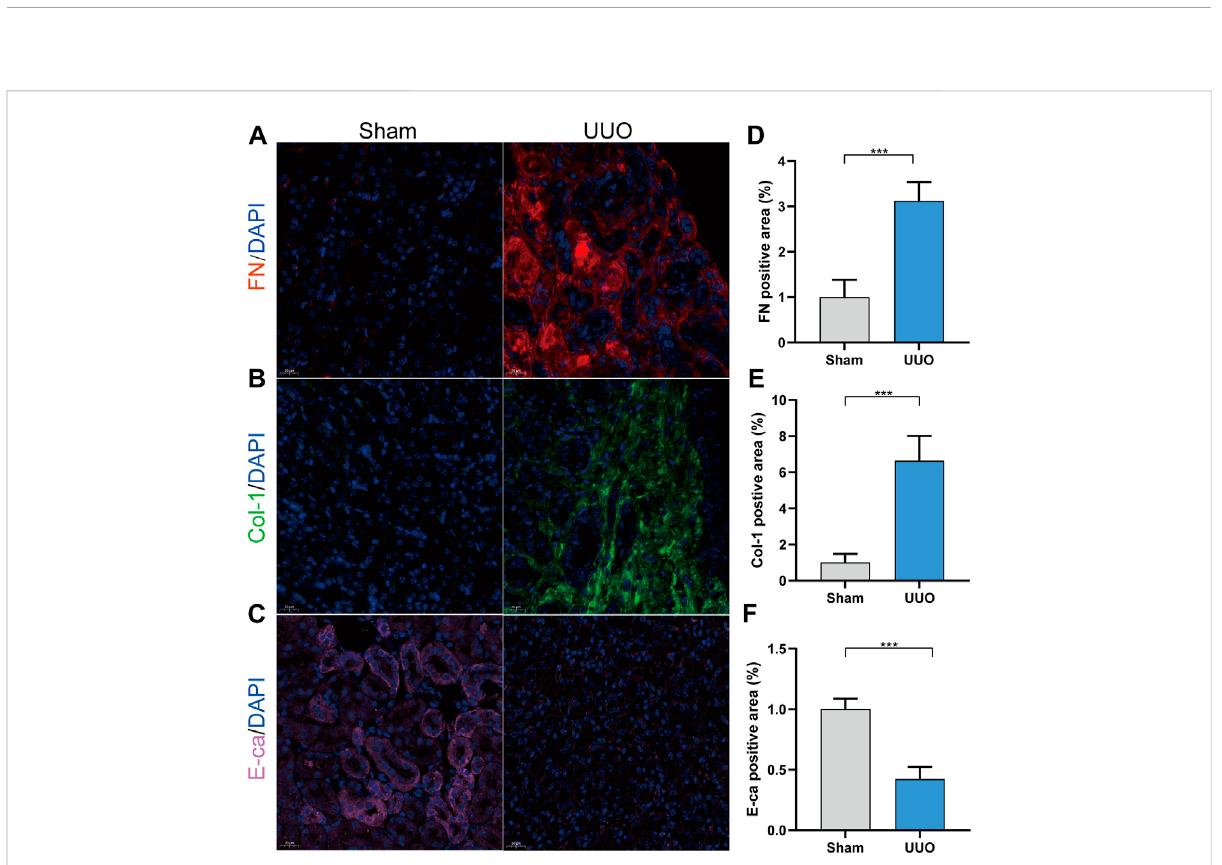
FIGURE 1 UUO model was conducted successfully. (A) Representative immuno fl uorescence of kidney sections stained with Fibronectin (red) and DAPI (blue). (B) Representative immuno fl uorescence of kidney sections stained with collagen I (green) and DAPI (blue). (C) Representative immuno fl uorescenceofkidneysectionsstainedwithE-cadherin(pink)andDAPI(blue). (D) Quantitativeanalysisofthe fi bronectinpositiveareainthe kidneysamples. (E) Quantitativeanalysis ofthecollagenIpositiveareainthekidneysamples. (F) Quantitative analysis oftheE-cadherin positive area in the kidney samples. *** p <